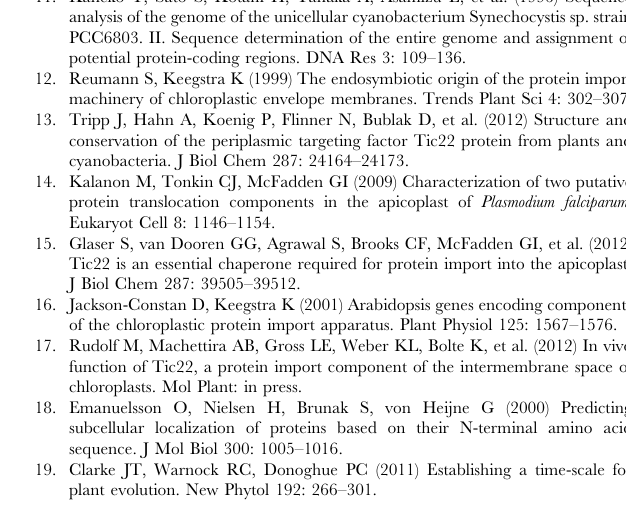
Figure S1 Annotated alignment of the Arabidopsis and pea Tic22 proteins. Full-length amino acid sequences of psTic22, atTic22-IV and atTic22-III, and exons 2–5 of At5g62650, were aligned by mafft [43]. Residues identical in sequences are highlighted in black, whereas similar residues are highlighted in grey. The locations of (predicted) transit peptide cleavage sites are indicated (the first mature residue is coloured green); the experimentally-determined cleavage site is shown for psTic22 [7], whereas TargetP-predicted sites are shown for the Arabidopsis proteins. Figure S2 Analysis of the localization of the Arabidopsis Tic22 proteins. A, Analysis of Tic22:YFP fusions in transfected Arabidopsis protoplasts. Wild-type Arabidopsis protoplasts were transfected with the indicated plasmids (atTic22-IV[full-length]:- YFP, atTic22-IV[1–224]:YFP and atTic22-IV[1–78]:YFP) and then analysed for YFP fluorescence (green, left panels) and chlorophyll autofluorescence (red, centre-left panels), as well as under brightfield illumination (right panels). An overlay of the YFP and chlorophyll images is presented (centre-right panels). Similar analyses of an equivalent series of three atTic22-III YFP constructs produced identical results (data not shown). Scale bar= 10 m m. B, Analysis of the localization of the Arabidopsis atTic22-III protein following in vitro import. Chloroplasts isolated from 14-day-old wild-type plants were used in protein import assays with either